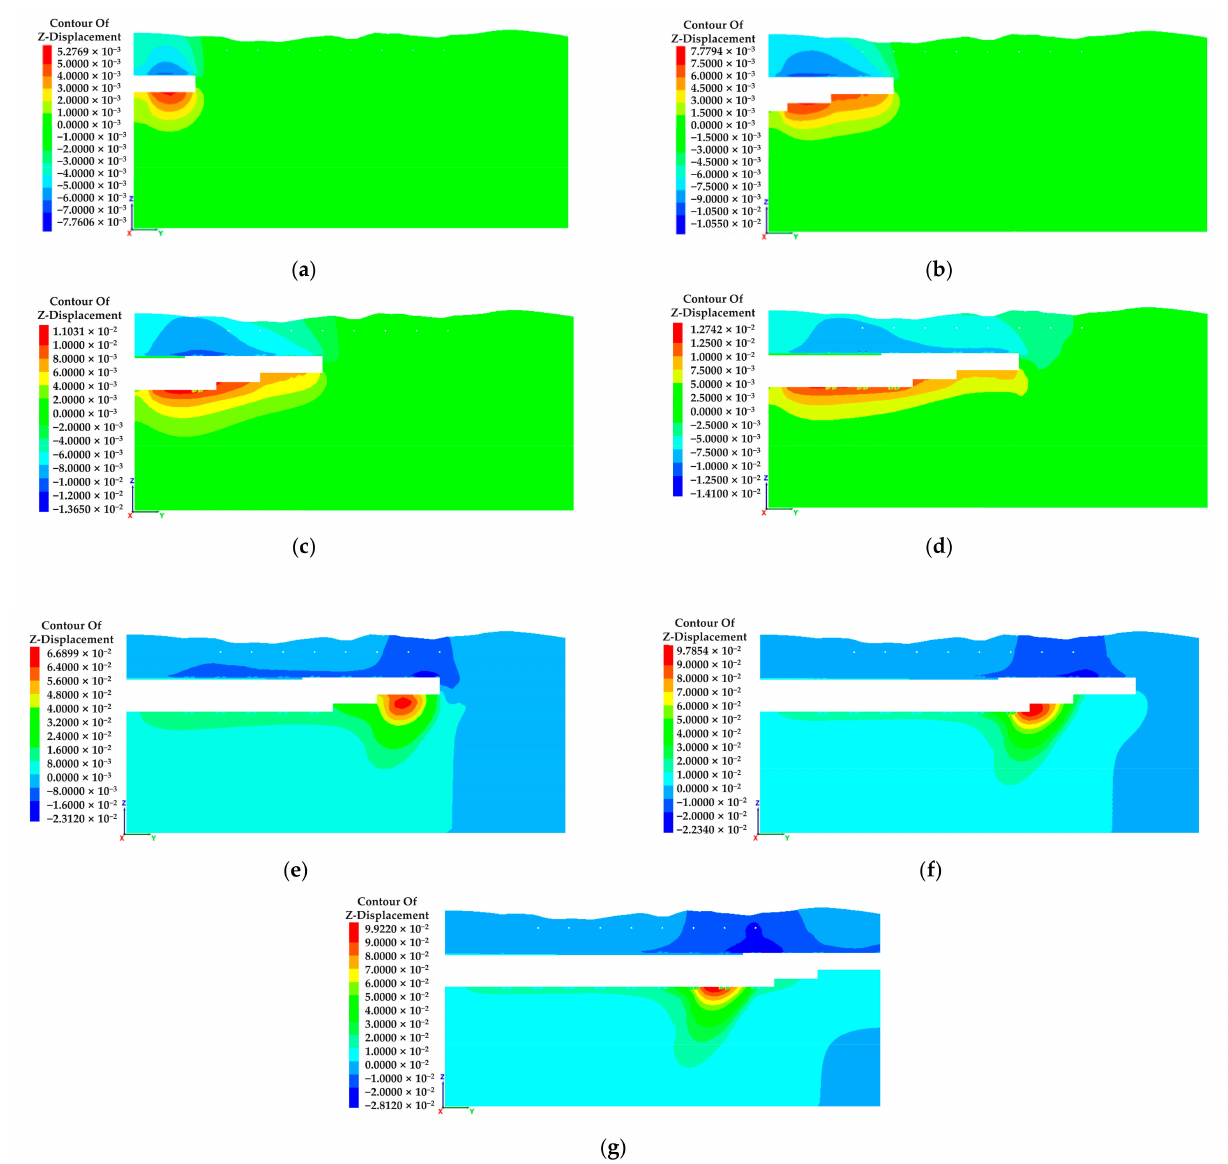
Figure 14. Vertical deformation of surface and surrounding rock during excavation of main tunnel (unit: m): ( a ) L = 20 m; ( b ) L = 40 m; ( c ) L = 60 m; ( d ) L = 80 m; ( e ) L = 100 m; ( f ) L = 120 m; ( g ) L = 140 m.